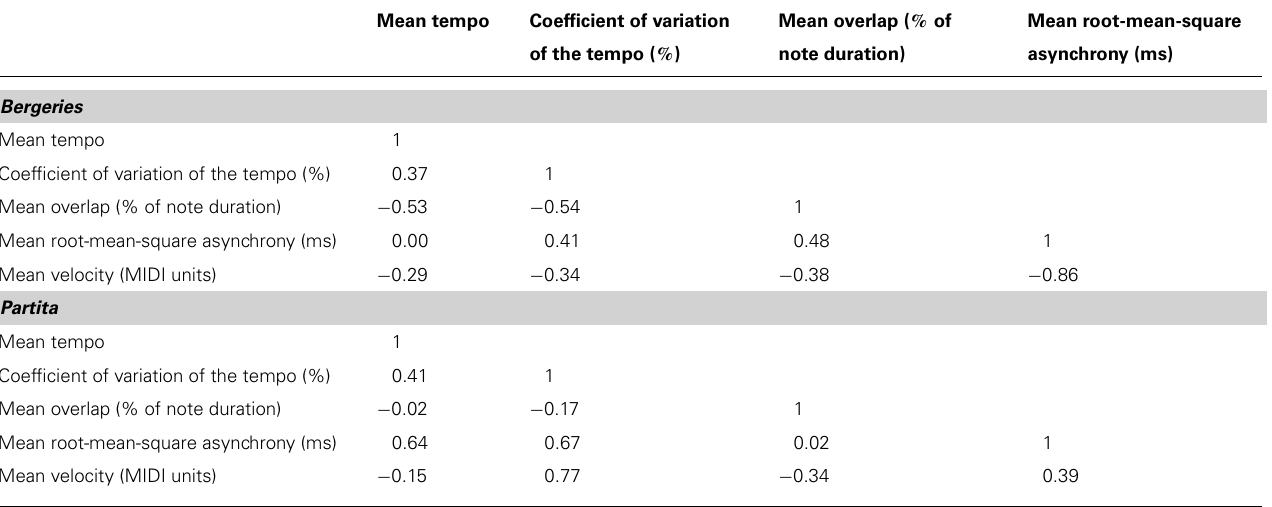
Table 4 | Correlation matrices on the mean values for the expressive parameters. Mean